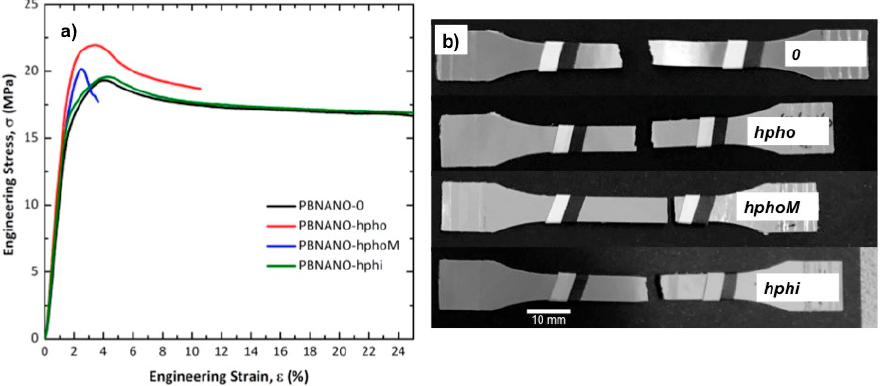
Figure 14. Representative engineering stress–strain curves of PBNANOs tested ( a ) and appearance of the deformation process zone after tensile tests ( b